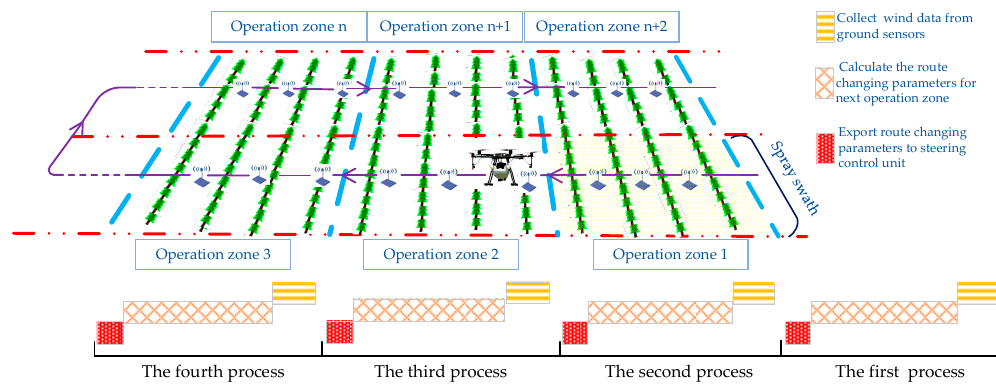
Figure 2. Operation environment and data process of the spraying UAV.